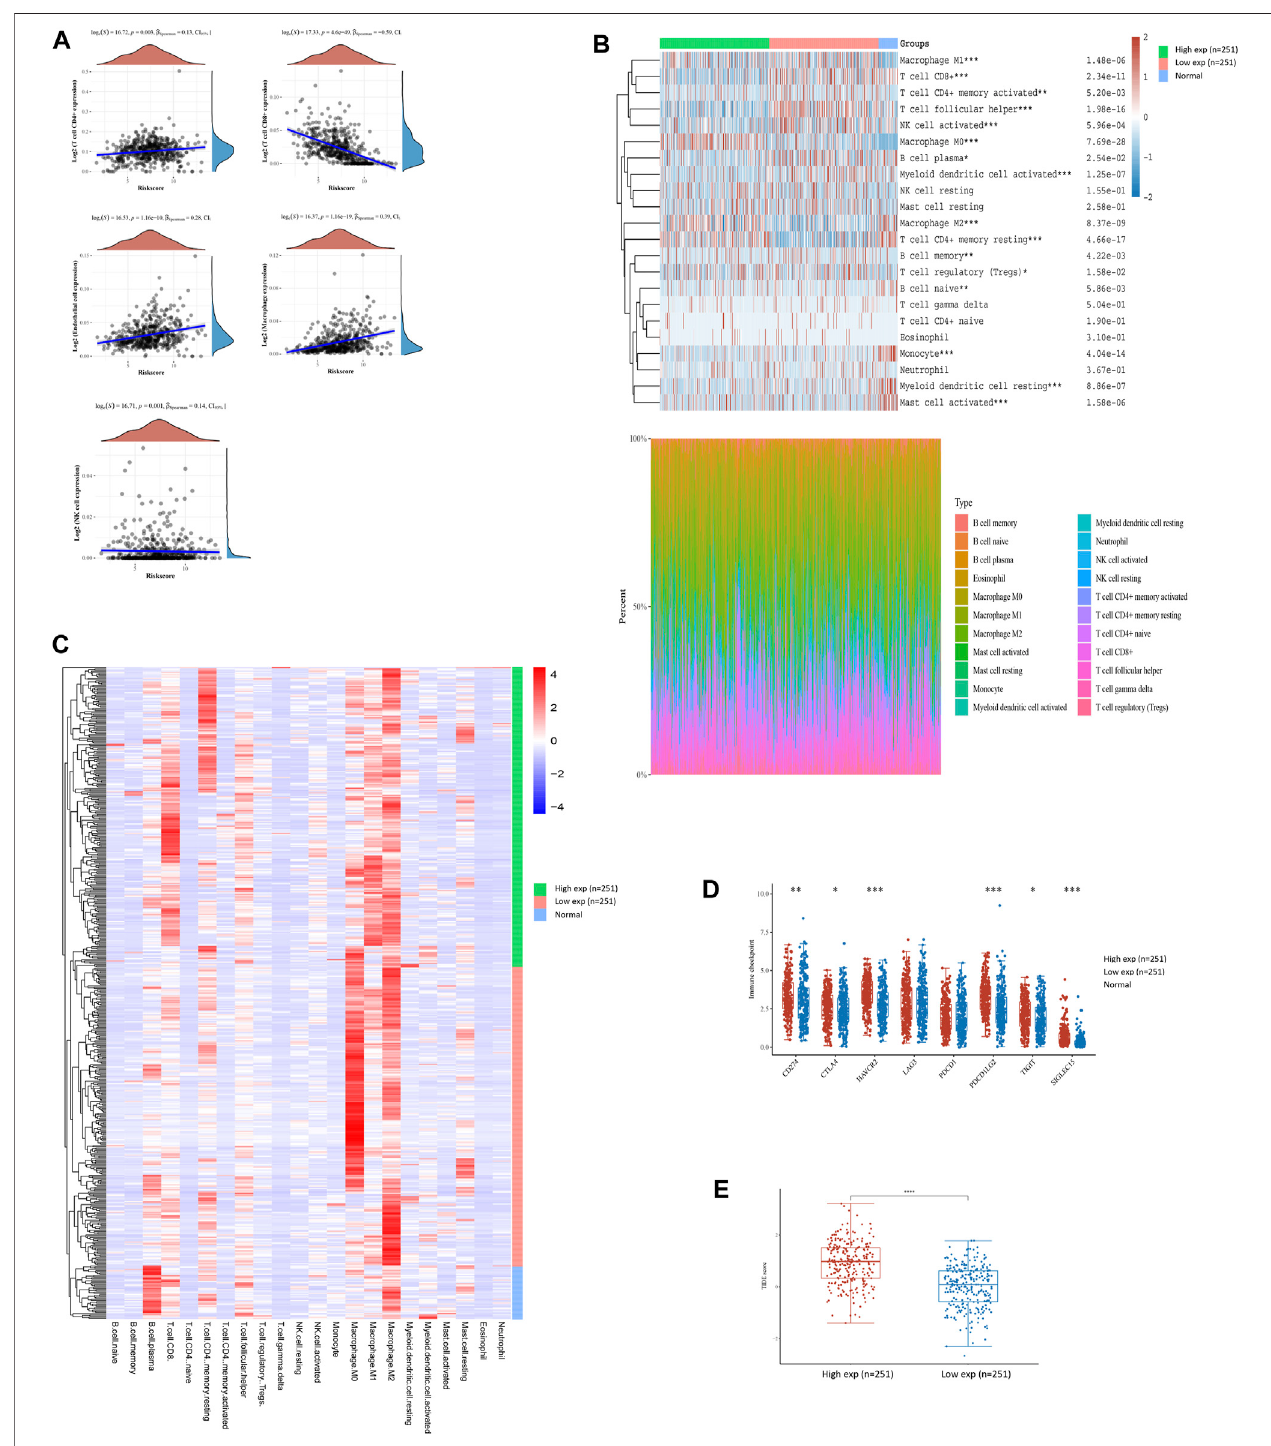
FIGURE 4 | FN1-related tumor immune microenvironment of HNSCC. (A) FN1 expression was positively correlated with CD4 + T cells, endothelial cells, macrophages, and NK cells and negatively correlated with CD8 + T cells. Scores and percentage abundance of tumor-in fi ltrating cells in FN1 high and FN1 low as well as normal samplesperformed using theCIRBSORT algorithm (B) and unsupervised clustering (C) . (D) Immune-checkpoint – relevant genes were differentially expressed in FN1 high and FN1 low samples. (E) Patients with higher expression level of FN1 had a higher TIDE score.